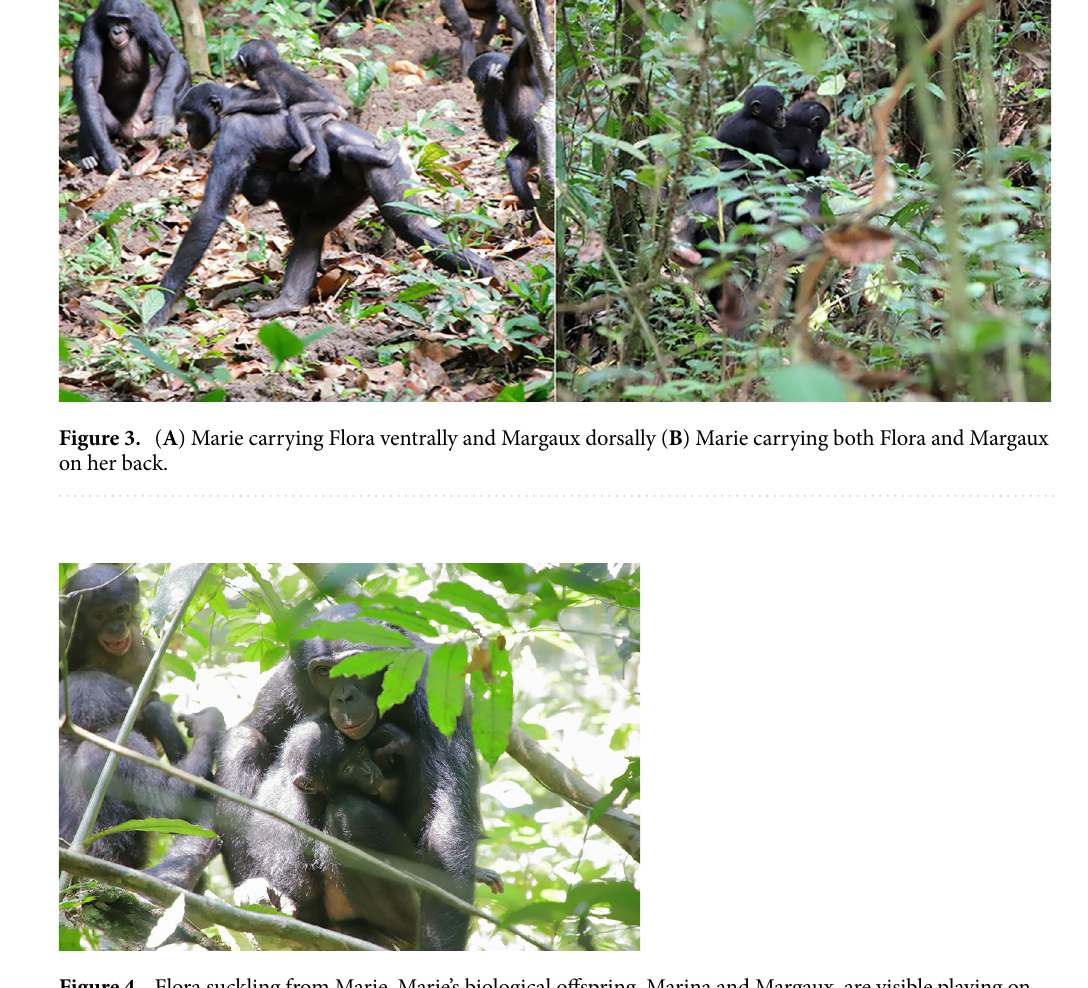
Figure 4. Flora suckling from Marie. Marie’s biological offspring, Marina and Margaux, are visible playing on the left side of the picture.